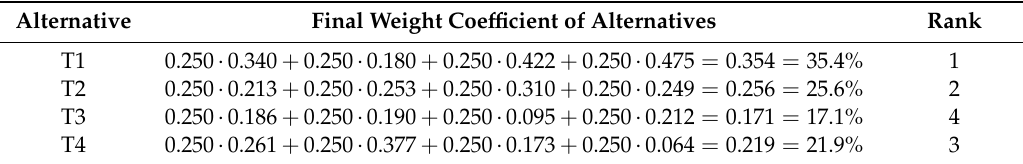
Table 17. Alternative ranking.